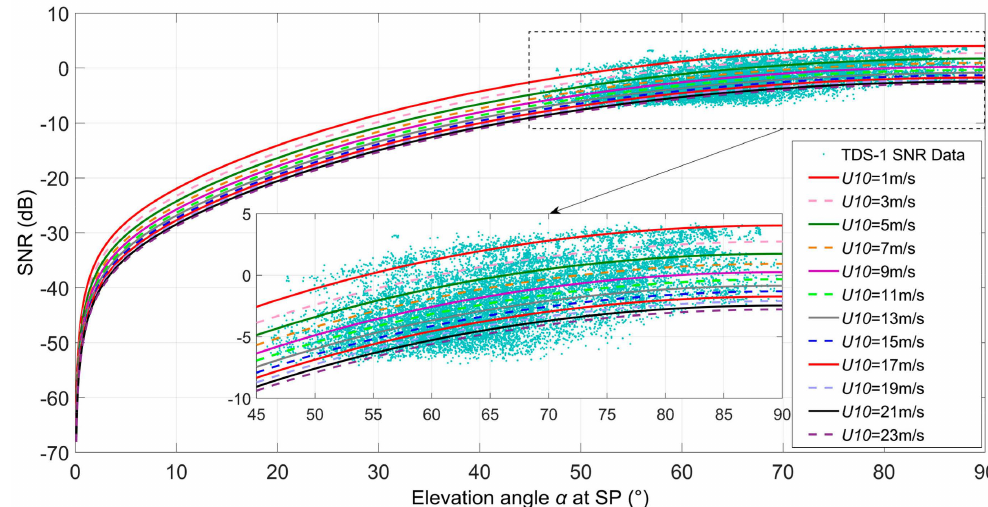
Figure 4. The SNR obtained according to nadir antenna signal-to-noise ratio model (NASNRM) as a function of the elevation angle. The U 10 is the wind speed at 10 m height above the sea surface. The inset is the SNR when the elevation angle at the range of 45 to 90 degrees.